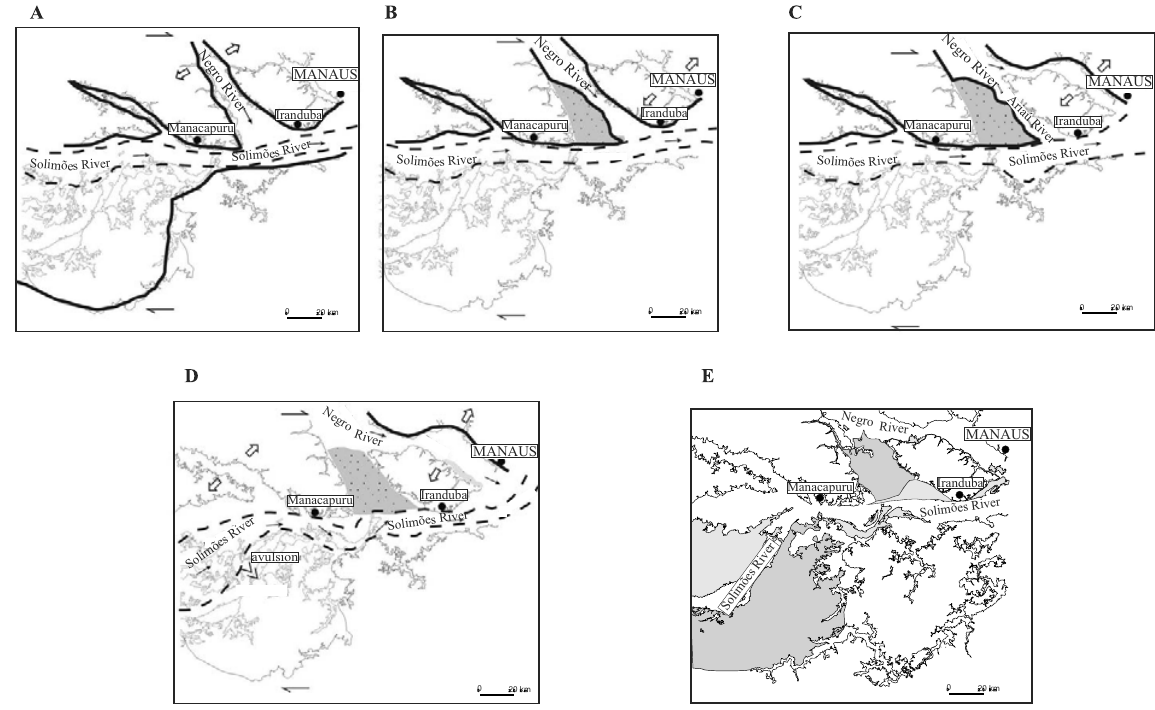
Fig. 10 – Paleogeographic model of the study region. In (A) the first stage where the Negro River passed into the region of the Ariaú River. (B) The normal fault of the Negro River (left margin) evolved also on the right margin enlarging the basin (C). The diversion of the Negro River to the east was the result of E-W fractures, following the fulfillment of the channel at Ariaú; (D) The E-W Solimões River formed meanders in the western portion. (E) The last stage shows the current morphology of the